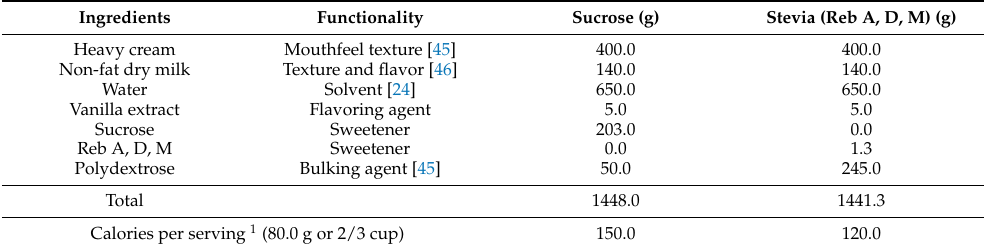
Table 1. The functionality of each ingredient for ice cream formulation and caloric